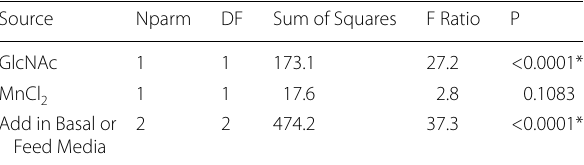
ANOVA results of three factors affecting glycan similarity using the distance value as the response.